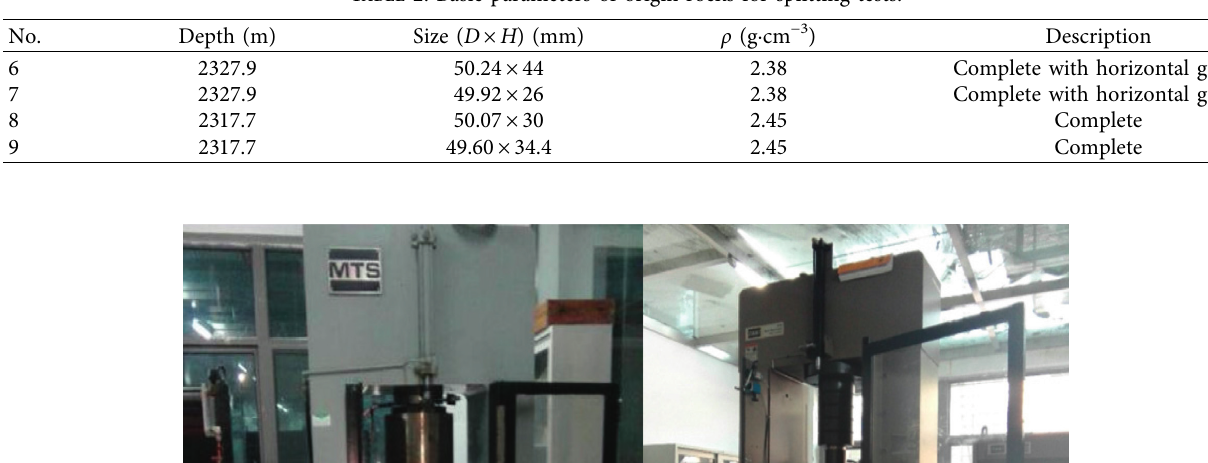
Table 2: Basic parameters of origin rocks for splitting tests.